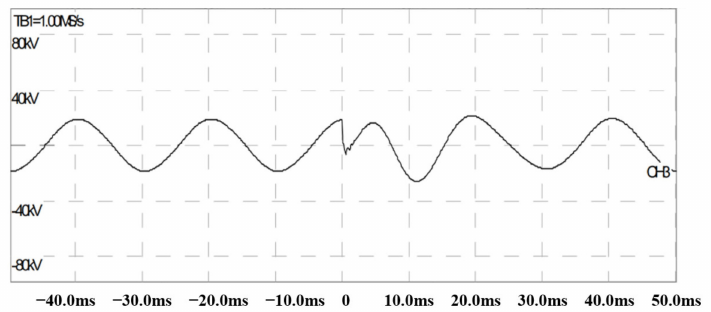
Figure 13. Arc voltage waveform.